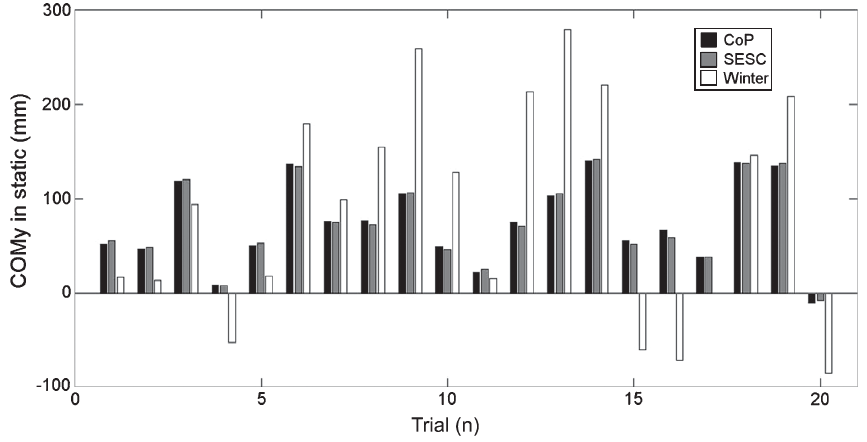
Fig. 8. CoP vs two methods to estimate the CoM on twenty static poses. Only CoM estimation method based on SESC gives accurate results. CoM estimation based on anthropometric tables (Winter, Table 5) introduce large errors.